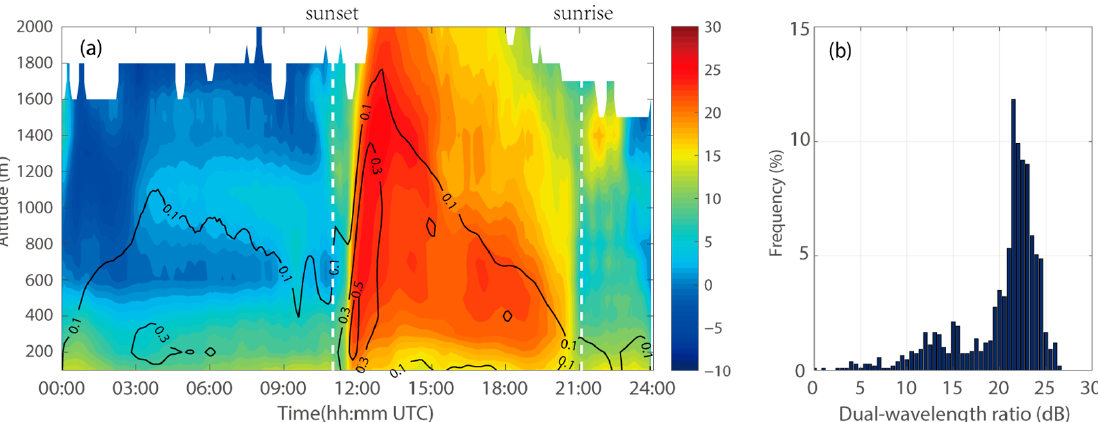
Figure 14. The DWR between the values of Figures 8 and 12. The time–height cross-section and the histogram of the DWR at nighttime are exhibited in ( a ) and ( b ), respectively. The black isopleth in ( a ) is the proportion of the X-band valid data. The bar chart ( b ) represents the normalized frequency distribution of the DWR from sunset to sunrise, and the data in the histogram from 19 dB to 25 dB occupy 80%.